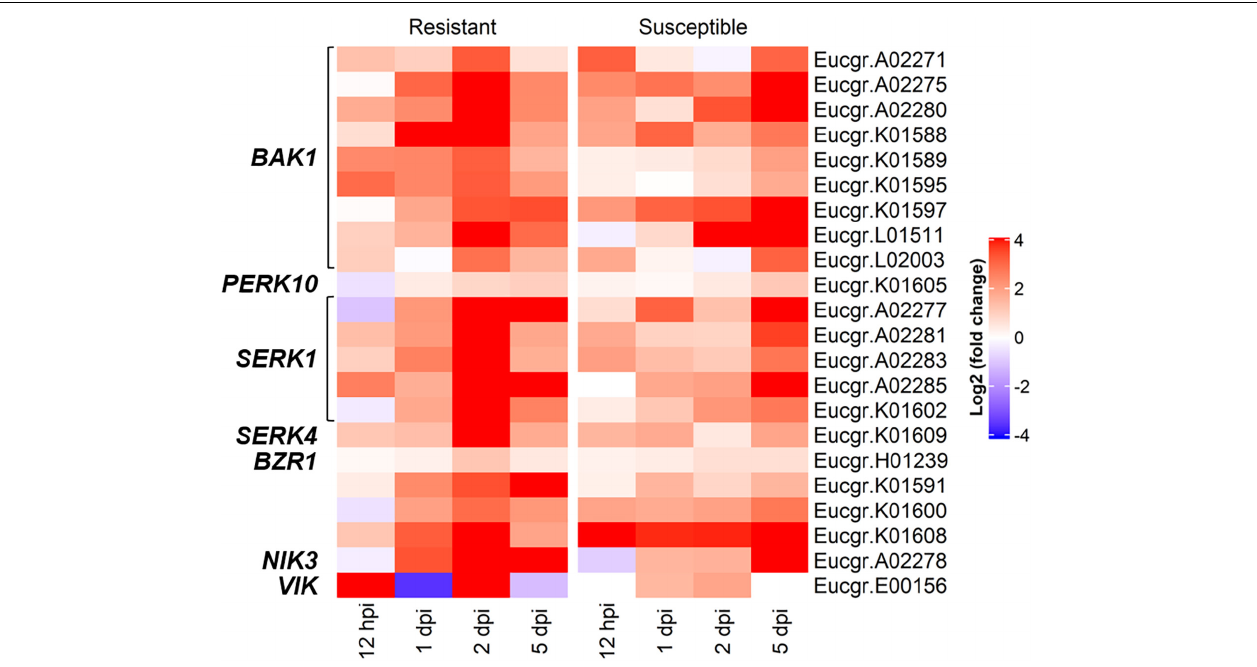
FIGURE 5 | The brassinosteroid mediated signaling pathway associated genes showing differentially expressed genes (DEGs) in both the R- and S-interactions over time, where red and blue indicate up- and down-regulation, respectively [log 2 (fold change)]. These genes were identified in GO BP enrichment.